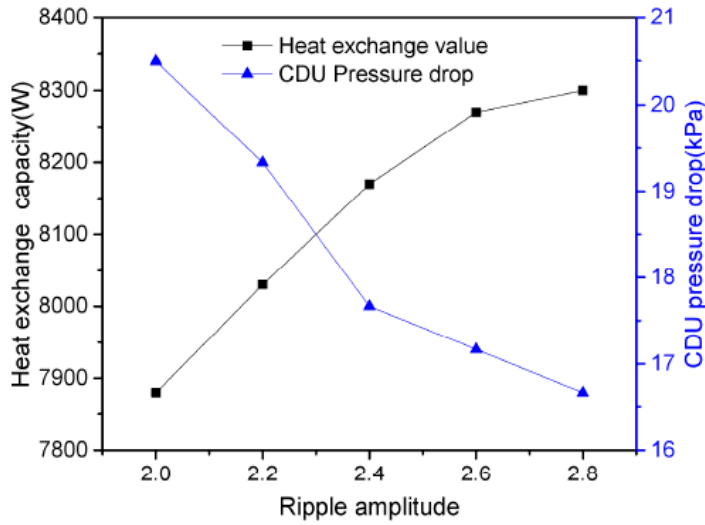
Figure 17. Heat transfer and pressure drop in the evaporator as a function of ripple